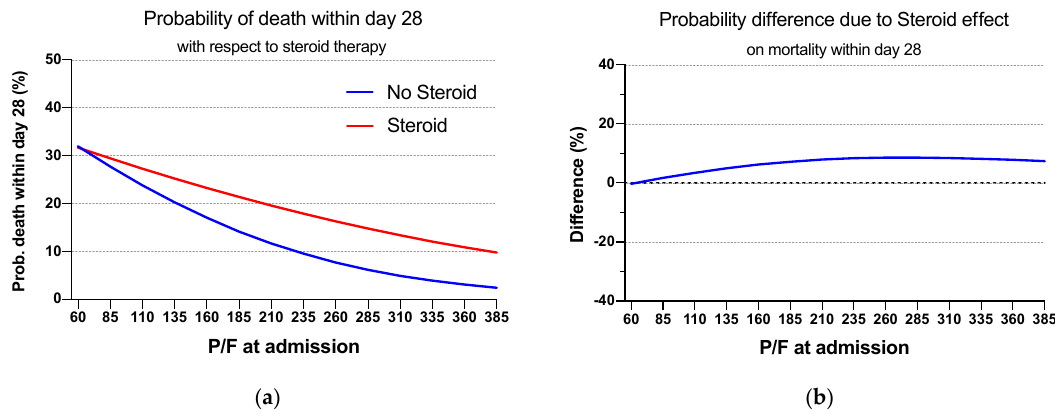
Figure A1. ( a ) Estimated probability of death within 28 days with respect to P/F values and steroid therapy. ( b ) Estimated difference in mortality within 28 days between exposed and unexposed cohort. Light blue shaded area shows confidence interval.